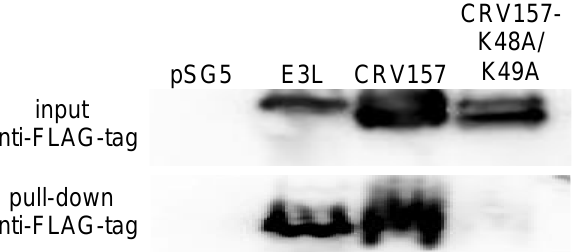
Figure 3. Pull-down of CRV157 and E3 with poly I:C. HeLa-PKR kd cells were transfected with 3 μg of the indicated plasmids. Protein lysates were analyzed by Western blot before (input) and after pull-down with poly I:C sepharose with an anti-FLAG antibody.